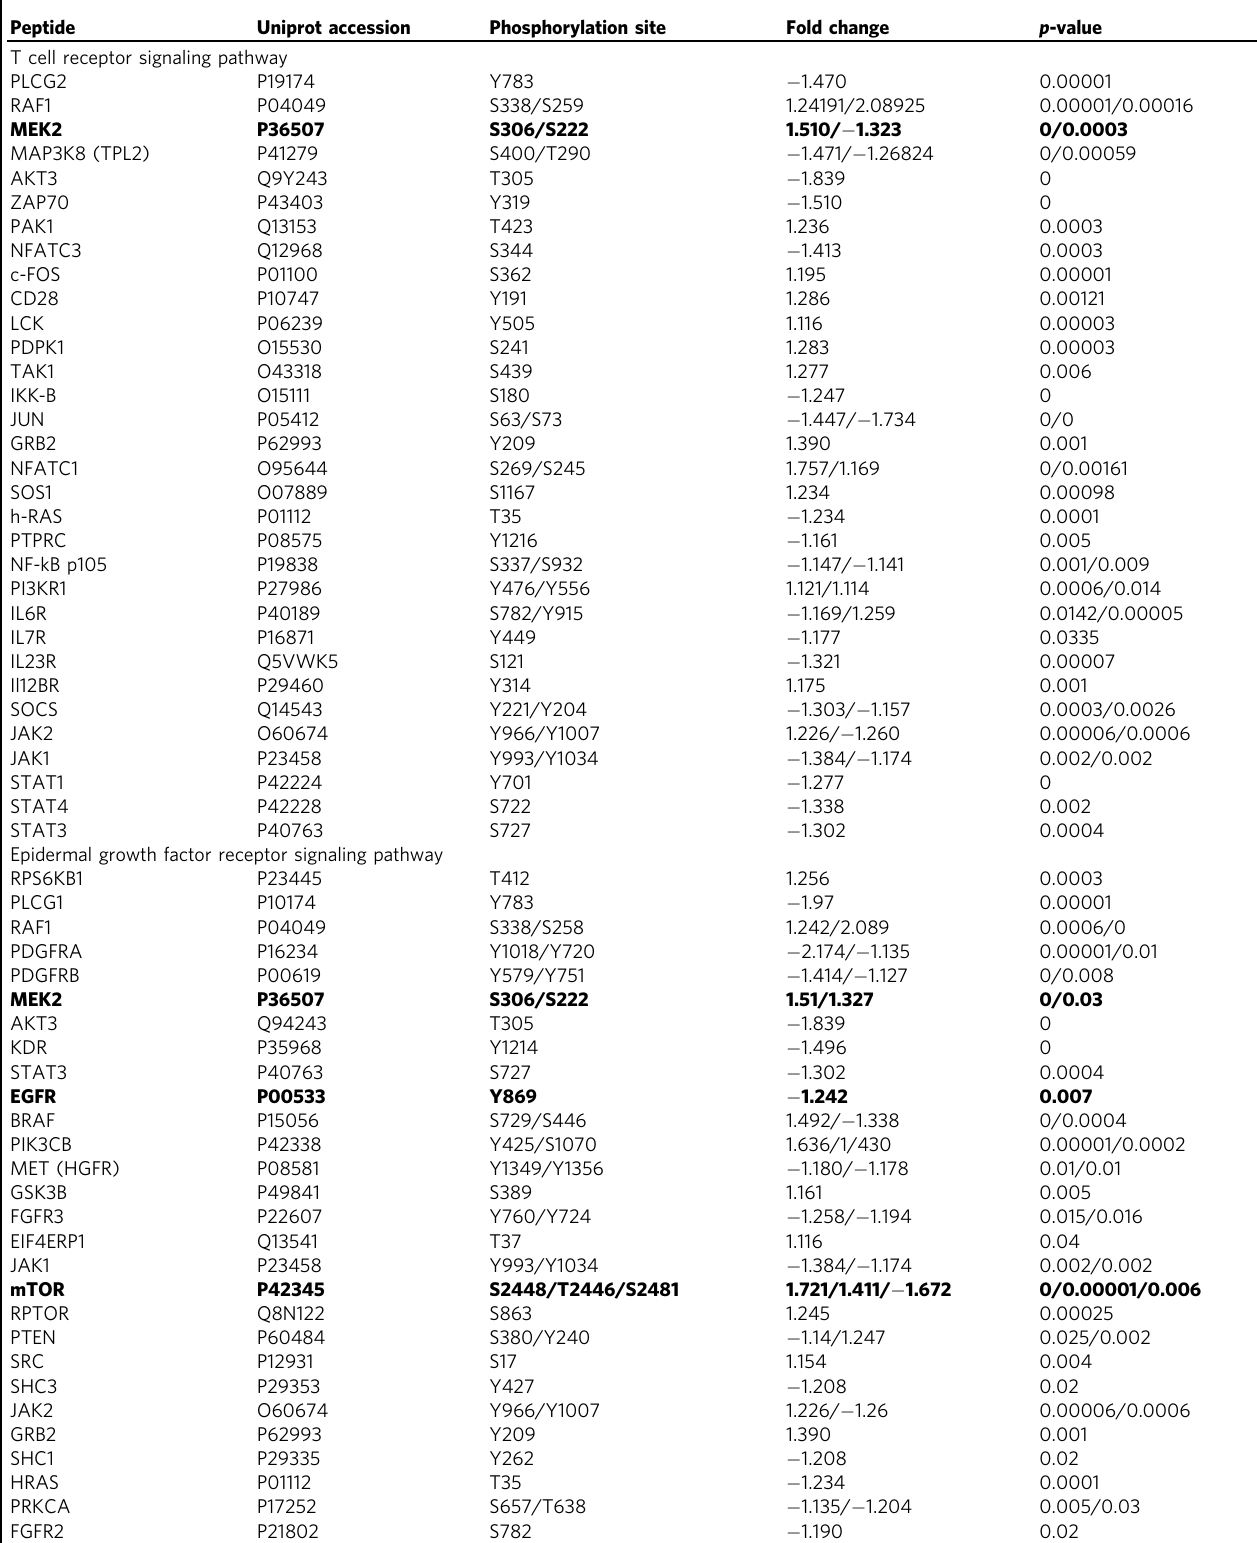
Table 2 Phosphorylation status of proteins in the T cell receptor and epidermal growth factor signaling pathways in ceca explants treated with reserpine.